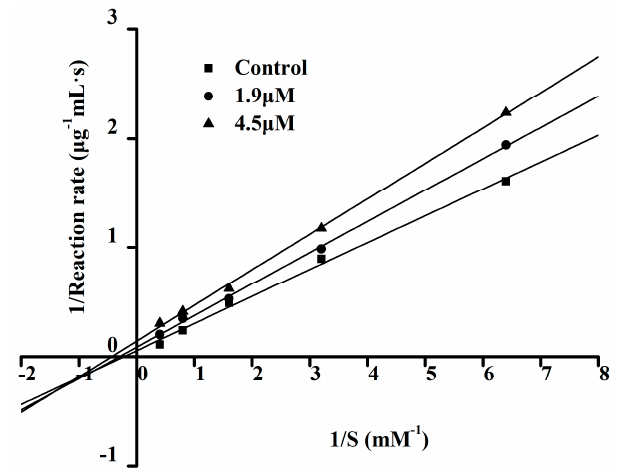
Figure 6. Lineweaver–Burk plots on ACE inhibitory activity of Ser-Tyr.